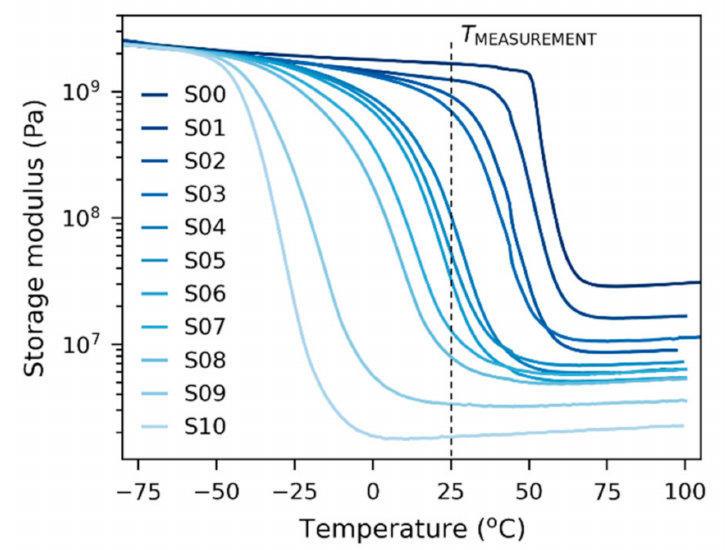
Figure 6. G (cid:48) - T curves from macroscale dynamic mechanical analysis (DMA) testing of all studied samples, illustrating the increase in storage modulus with the increasing glass transition